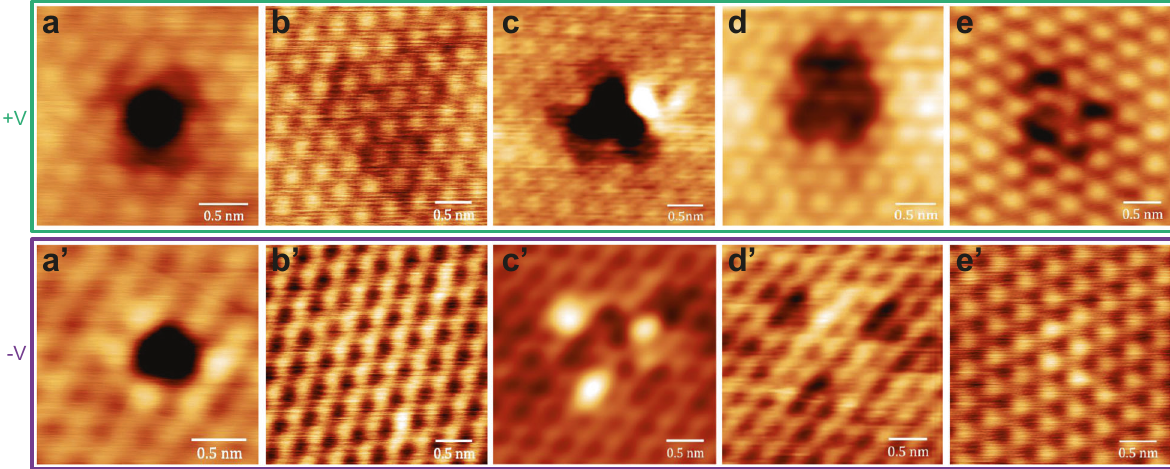
Fig. 2 Atomically resolved STM images of fi ve types of point defects A to E scanned under positive and negative bias voltages. Top panel: STM images ( a – e ) of defects scanned under positive bias (empty states). Bottom panel: STM images ( a ′ – e ′ ) of the same defects scanned under negative bias ( fi lled states). Scanning parameters are: for type A defect ( V = ±0.55 V, I = 580 pA). Type B defect ( V = ±0.85 V, I = 175 pA). Type C defect ( V = ±0.85 V, I = 185 pA). Type D defect ( V = ±0.85 V, I = 185 pA). Type E defect ( V = ±0.9 V, I = 250 pA).